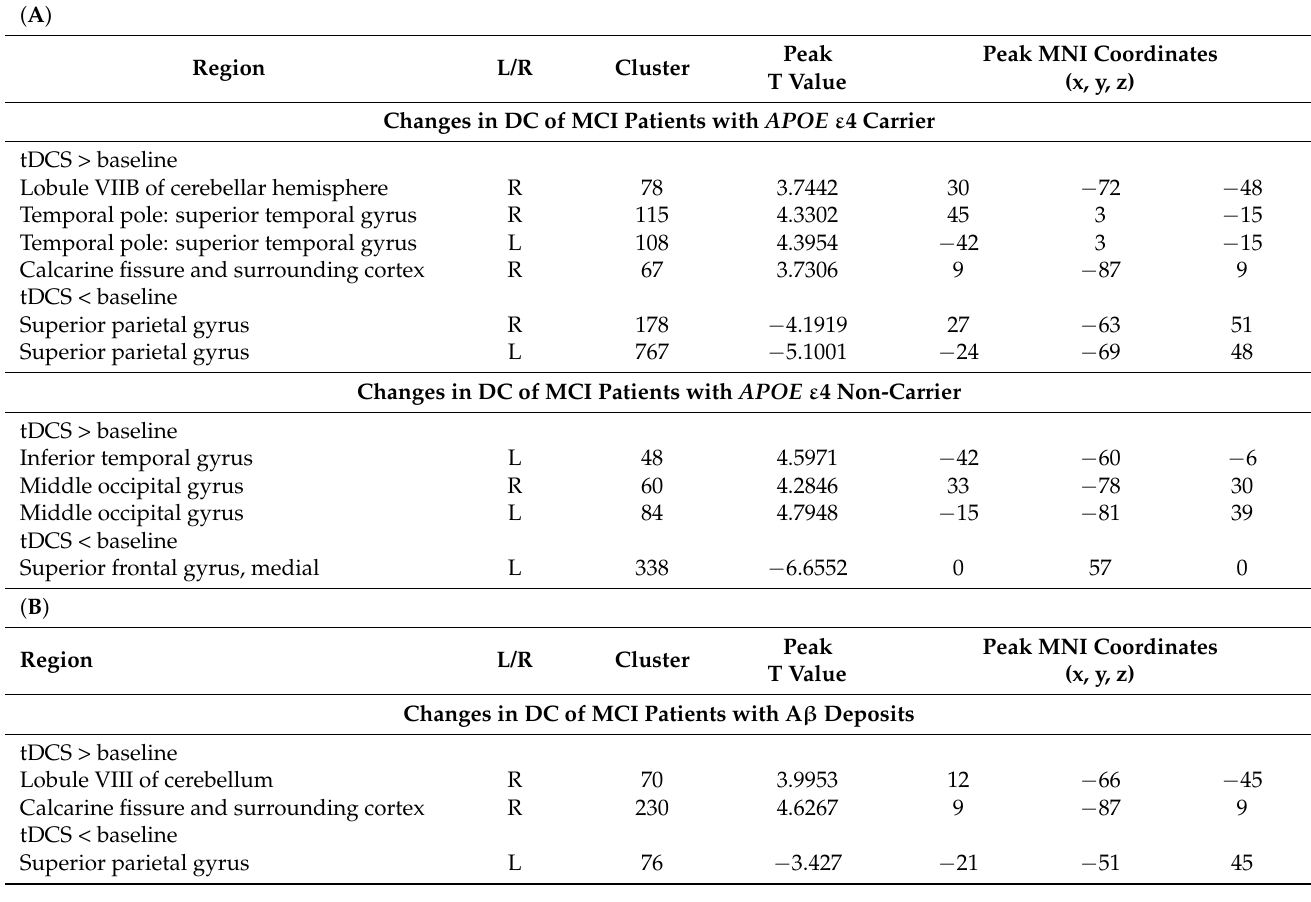
Table 3. Changes in DC of MCI patients after tDCS, according to ( A ) APOE genotype and ( B ) A β